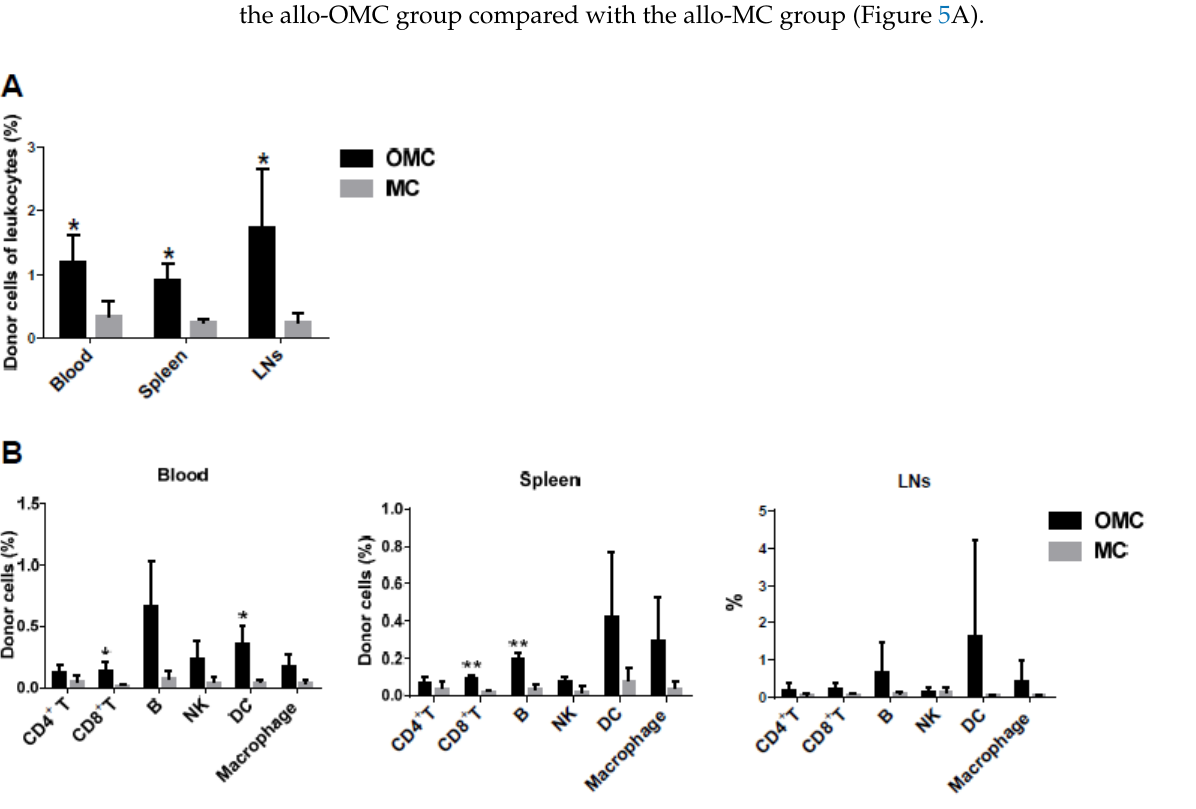
Figure 5. Mixed chimerism in lymphoid organs of face-allotransplanted mice. ( A ) Percentages of donor cells (H2 d ) in the blood, spleen, and lymph nodes (LNs) of allogeneic osteomyocutaneous (OMC) and myocutaneous (MC) groups were analyzed using flow cytometry. Immune cells were isolated from the lymphoid organs of mice from each group receiving 0.6 mg/kg of FK506 on POD 14. The donor cells were stained for H2 d+ cells. Data were collected from three mice in each group. The statistical data are presented as mean ± SD. ( B ) Multilineage chimerism developments in lymphoid organs of face-allotransplanted mice. Percentages of donor cells (H2 d ) in the blood, spleen, and lymph nodes of allogeneic OMC and MC groups were examined by flow cytometry. Immune cells were isolated from the lymphoid organs of mice from each group receiving 0.6 mg/kg of FK506 on POD 14. The multilineage donor cells were stained for H2 d+ CD4 + T and H2 d+ CD8 + T, H2 d+ CD19 + B, H2 d+ NK1.1 + NKs, H2 d+ CD11c + DCs, H2 d+ CD11b + macrophage cells. T, B, and NKs were gated from lymphocytes, and DCs and macrophages were gated from lymphocytes and monocytes for flow cytometry analysis. Data were collected from three mice in each group. The statistical data are expressed as mean ± SD. The allogeneic OMC group was compared with the MC group for each lymphoid organ (* p < 0.05 and ** p < 0.05, Student’s t test).